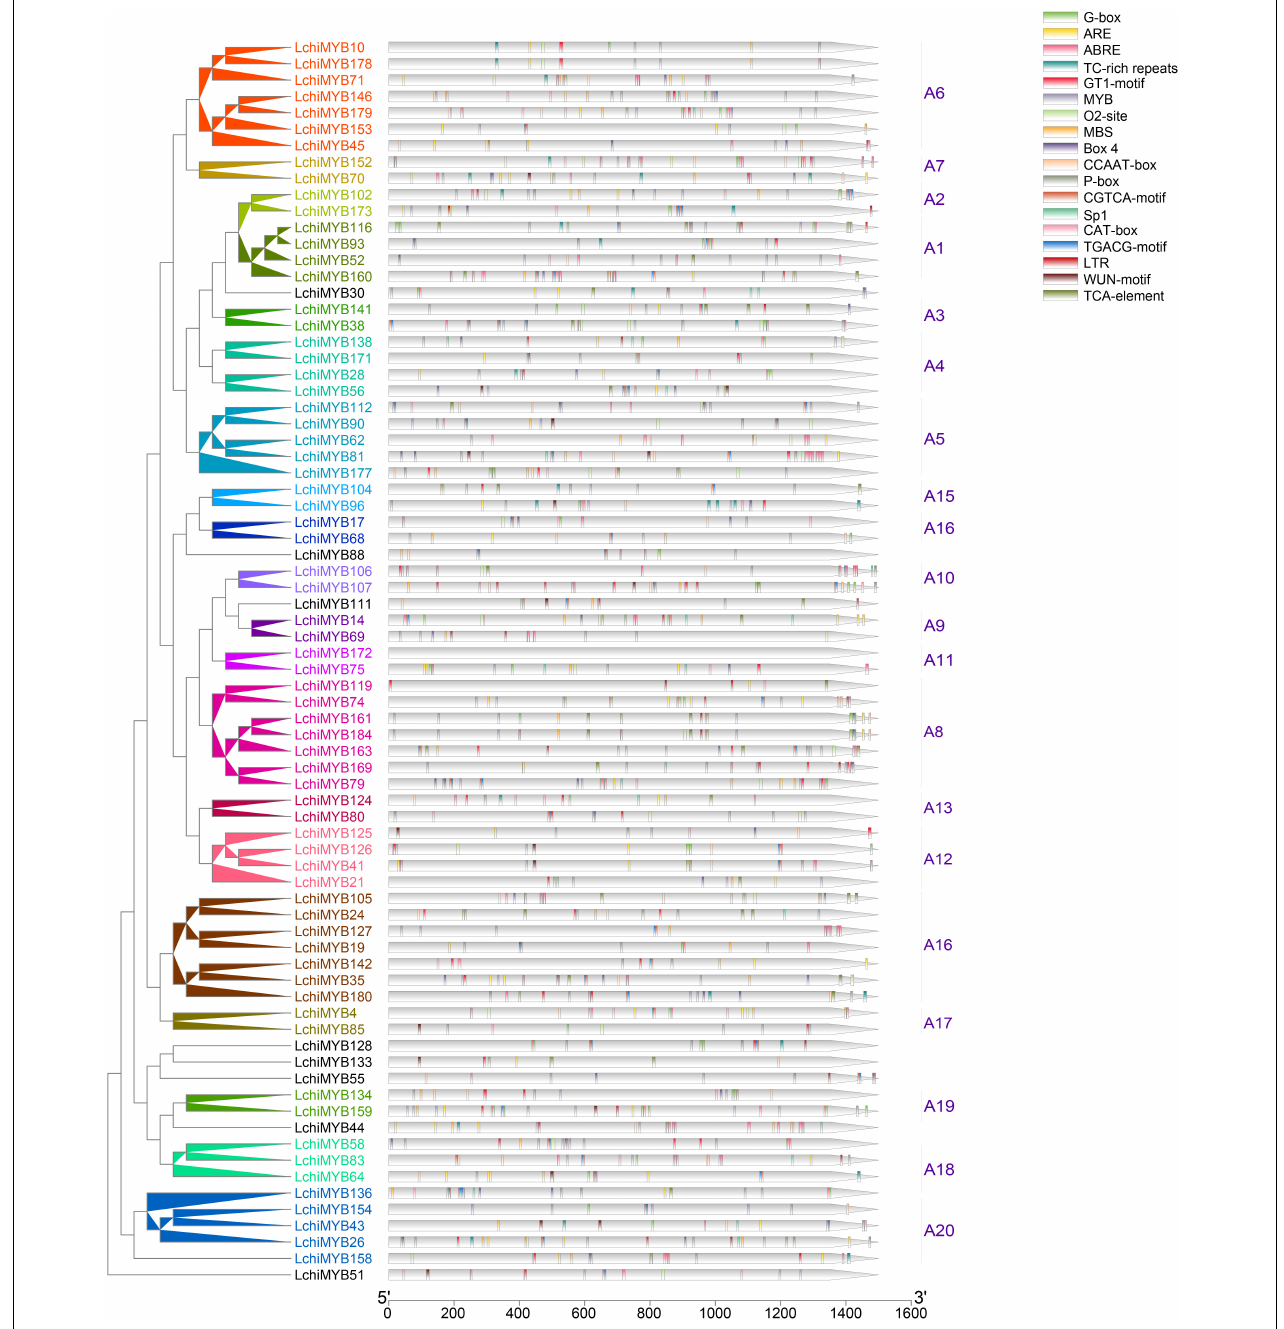
FIGURE 6 | LchiMYB cis -acting elements. Displayed is an unrooted phylogenetic tree constructed, using Beast (v2.6.2) set to the Bayesian method. The legend contains 18 cis -acting elements identified within the 1.5-kb long LchiMYB promoter sequences; the tick marks represent the length of the promoter sequences. Different cis -acting elements are color coded. The corresponding groups were labeled (e.g., A1) with different colors on the branches and gene